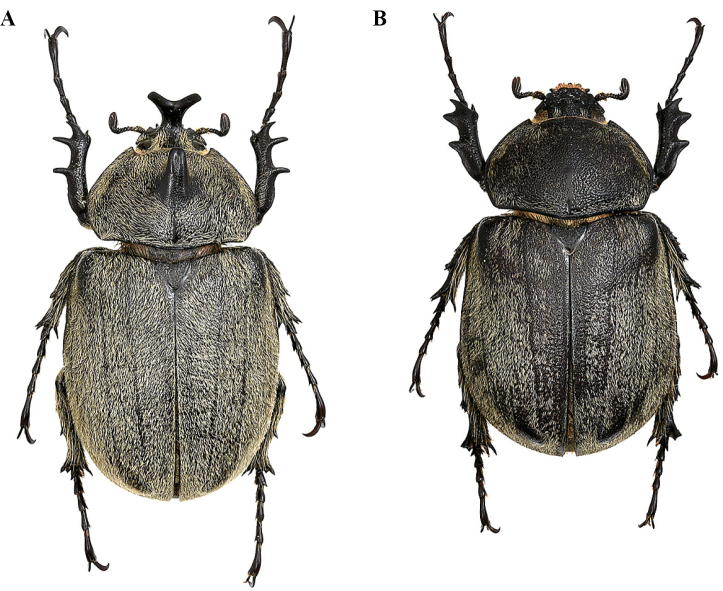
AM.
joergenseni
joergenseni ♂ BM.
joergenseni
joergenseni ♀.